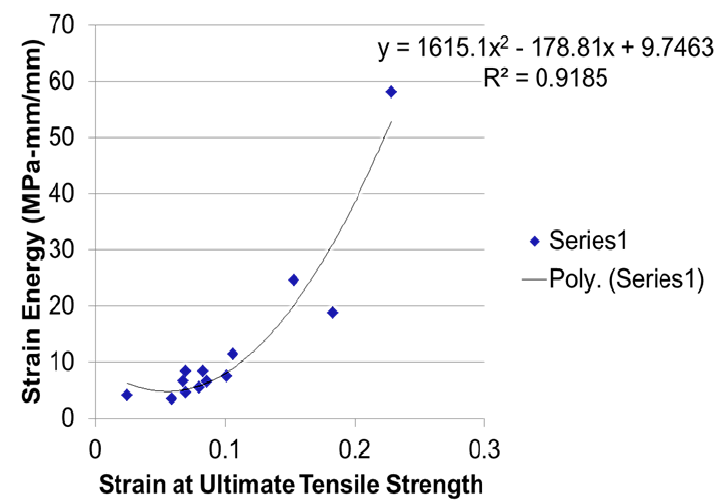
Figure 6. Strain energy vesrsus strain at ultimate tensile strength [15].